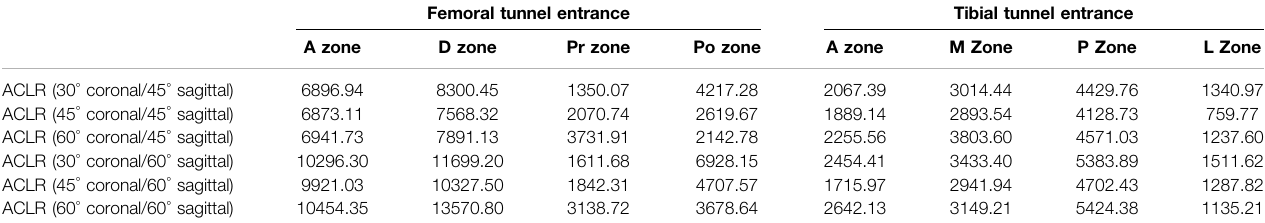
TABLE 4 | Maximum strain ( μ -strain) at different zones of the tunnel entrances following ACLR by AM portal technique in several coronal and sagittal obliquity angles.